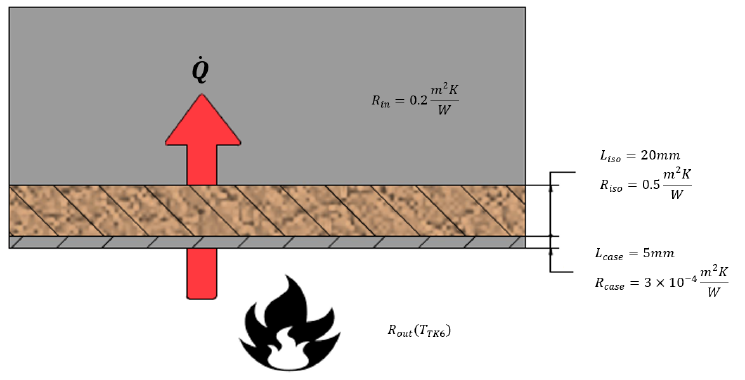
Figure 7. Model of the internal battery temperature